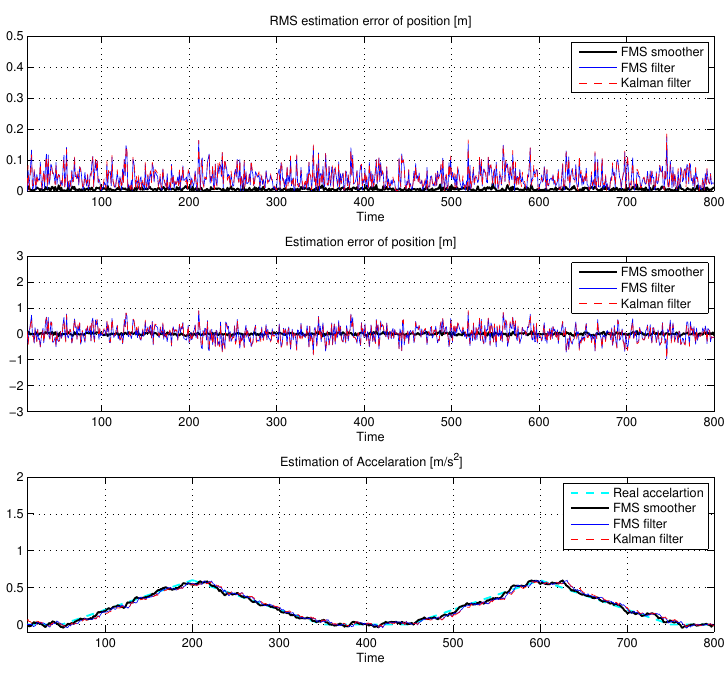
Figure 3. Simulation result for slowly changing